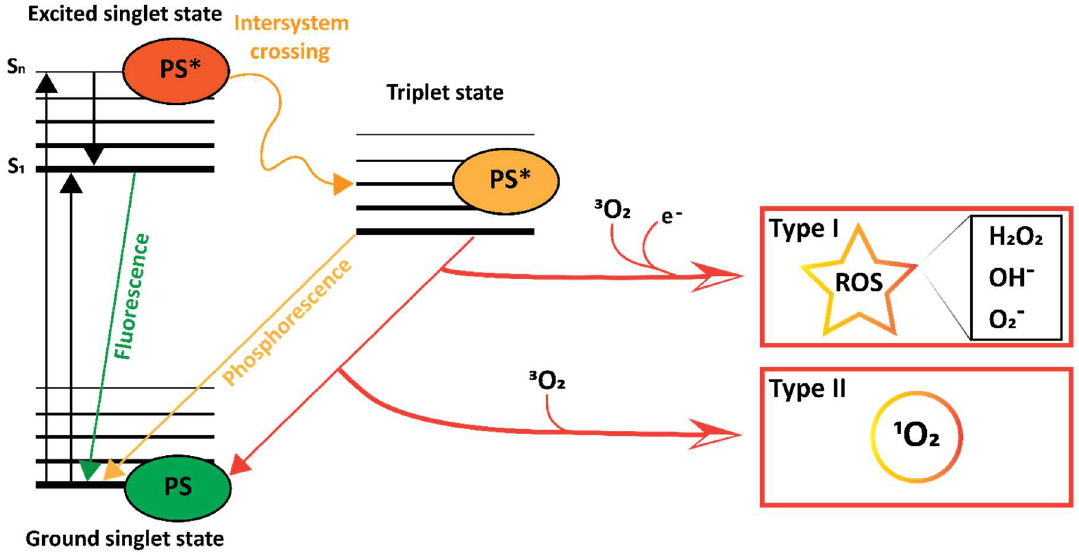
Figure 2. Photodynamic effect.